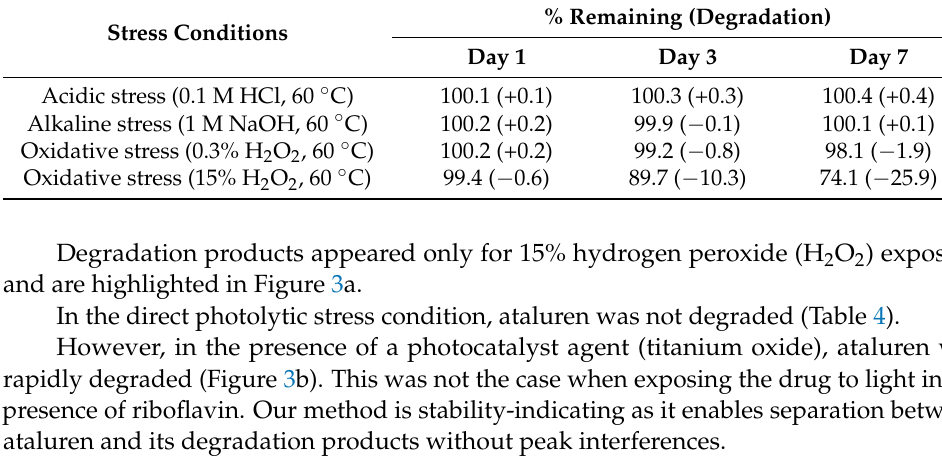
Figure 2. The 95% accuracy profile according to the ataluren level. The determined values of LOD and LOQ were 6.8 µg/mL and 11.1 µg/mL, respec- tively, calculated using slope and Y-intercept. Table 2. Relative standard deviation values (%) for repeatability and intermediate precision (IQC). Definition: relative standard deviation (RSD). Table 3. Forced degradation studies of 1% eye drop oily